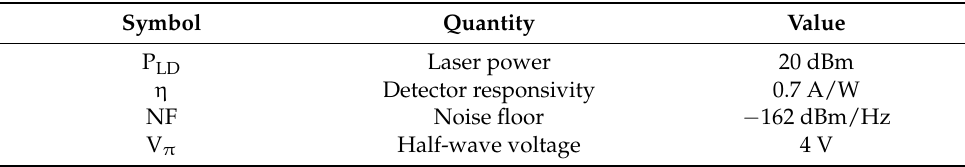
Table 1. Device parameters used to calculate the CS-AMZM.